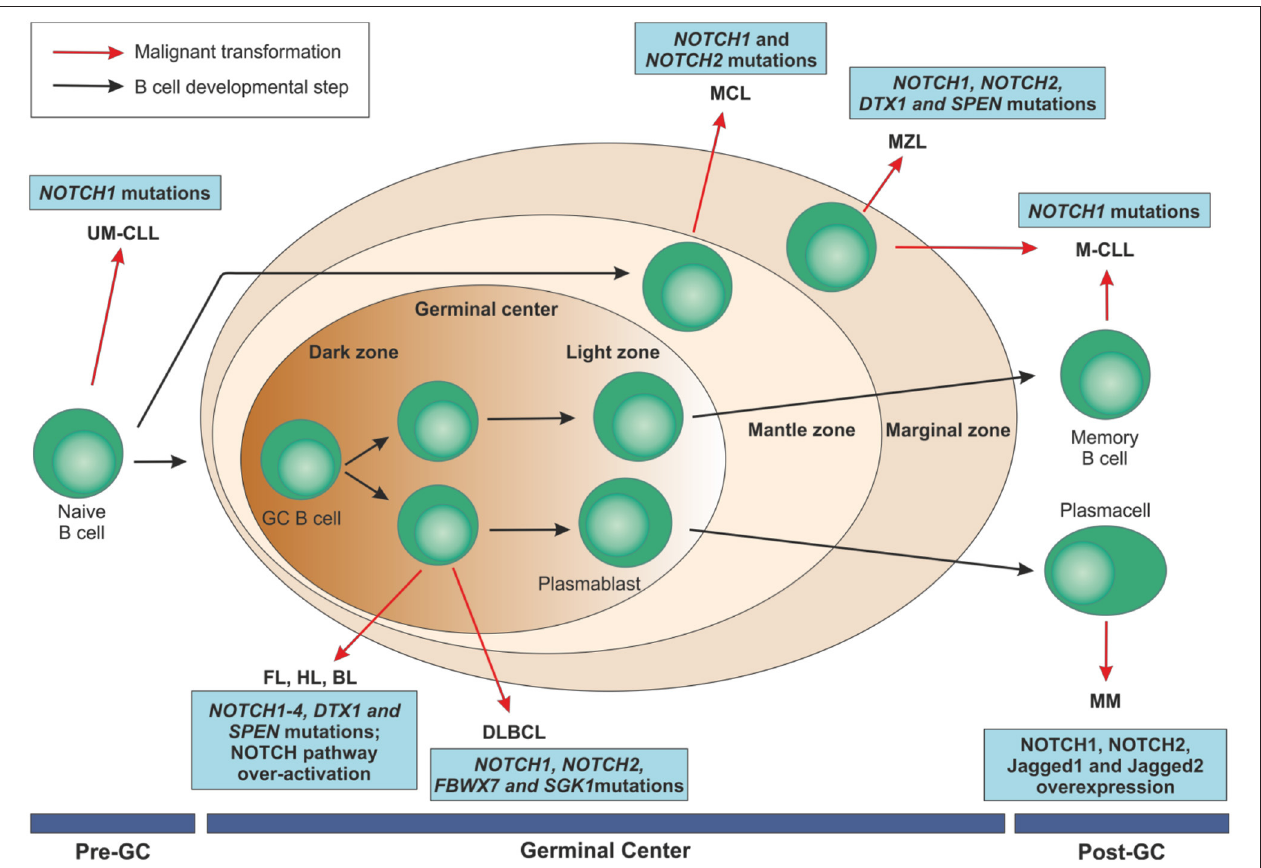
FIGURE 5 | Mature B cell malignancies classification according to their normal counterpart and overview of NOTCH implications in these disorders. After antigen contact, naïve B cells are activated and enter the germinal centers. Maturation through a T cell dependent process leads to centroblast differentiation in the dark zone with high proliferation rate and somatic mutations of immunoglobulin variable regions and continue their maturation through the light zone. After that, they can become memory B cells or terminally differentiated plasmacells. On the contrary, transitional B cells are selected into a mature B cell repertoire in a T cell-independent way through the marginal zone of the spleen. B cell malignancies can arise from B lymphocytes at each maturation step. NOTCH family members have been identified as recurrently mutated in some of these disorders or to be over-expressed, ultimately resulting in an aberrant activation of the pathway.UM-CLL, IGVH unmutated